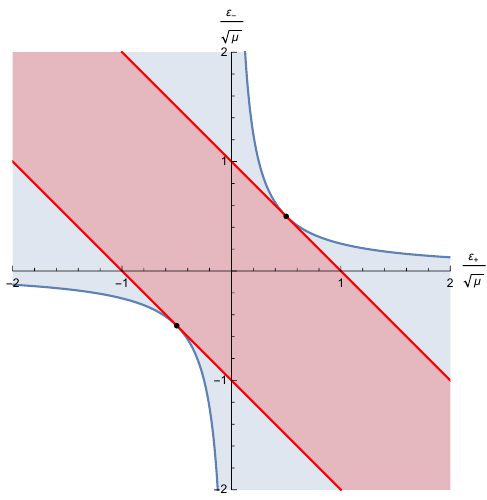
Figure 1 . ( ε + , ε − ) parameter space. The bound (2.11) is illustrated in red. The second bound of (2.12) is illustrated in blue. The two bounds coincide at ε + = ε − =